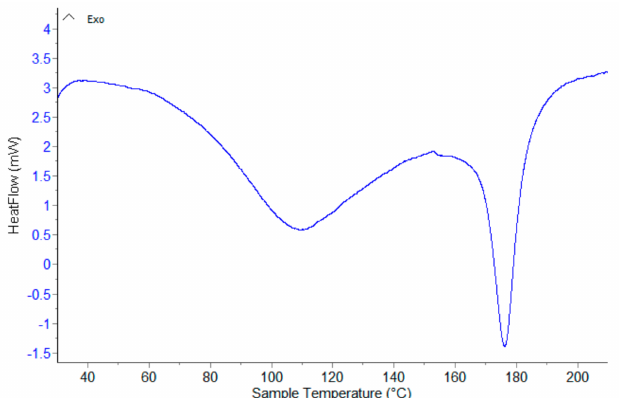
Figure A5. The DSC thermogram of RUT-HP- β -CD physical mixture, dynamic nitrogen atmosphere, β = 10 K min − 1 .